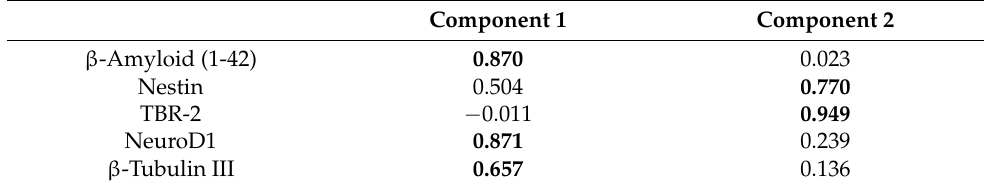
Table 1. Descriptive analysis of the rotated component loadings observed after applying a PCA